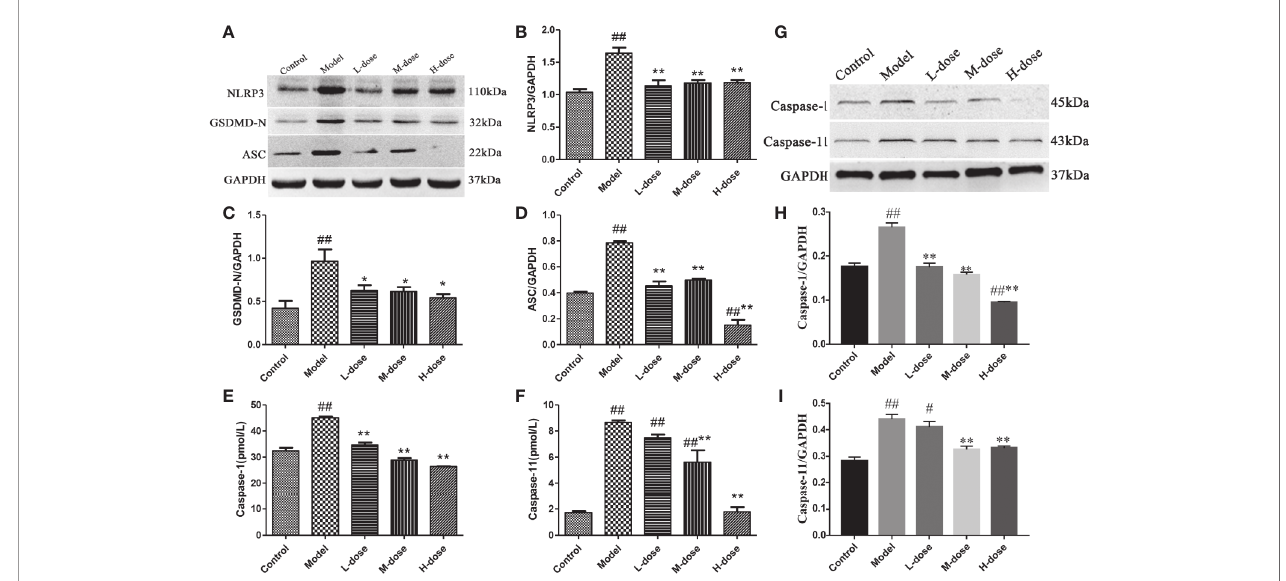
FIGURE 7 | SLBZS reduces the progression of colitis by inhibiting pyroptosis. (A – D) The expression levels of NLRP3, GSDMD-N, and ASC were analyzed by western blotting. (E , F) A kit was used to measure caspase-1 and caspase-11 levels. (G – I) Protein expression of caspase-1 and caspase-11. The data are shown as the mean ± S.E.M. # P < 0.05, ## P < 0.01 vs. the control group; * P < 0.05, ** P < 0.01 vs. the model